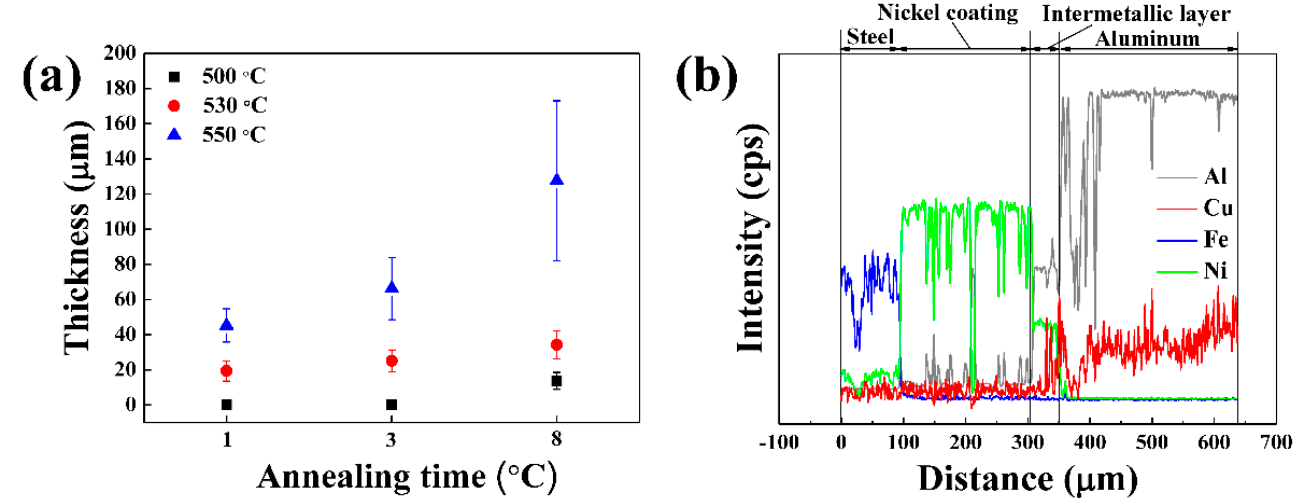
Figure 3. ( a ) The quantitative analysis of intermetallic layer thickness under different solution temperature and annealing times and ( b ) electron probe X-ray microanalyzer (EPMA) line mapping of the Al/Fe alloys hybrid structure’s interface under 550°C heat treatment, followed by furnace cooling.